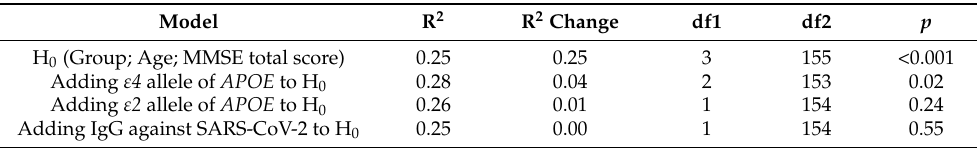
Table 6. Effect of adding APOE genotype and anti-SARS-CoV-2 IgG on the initial regression model of changes of MMSE total